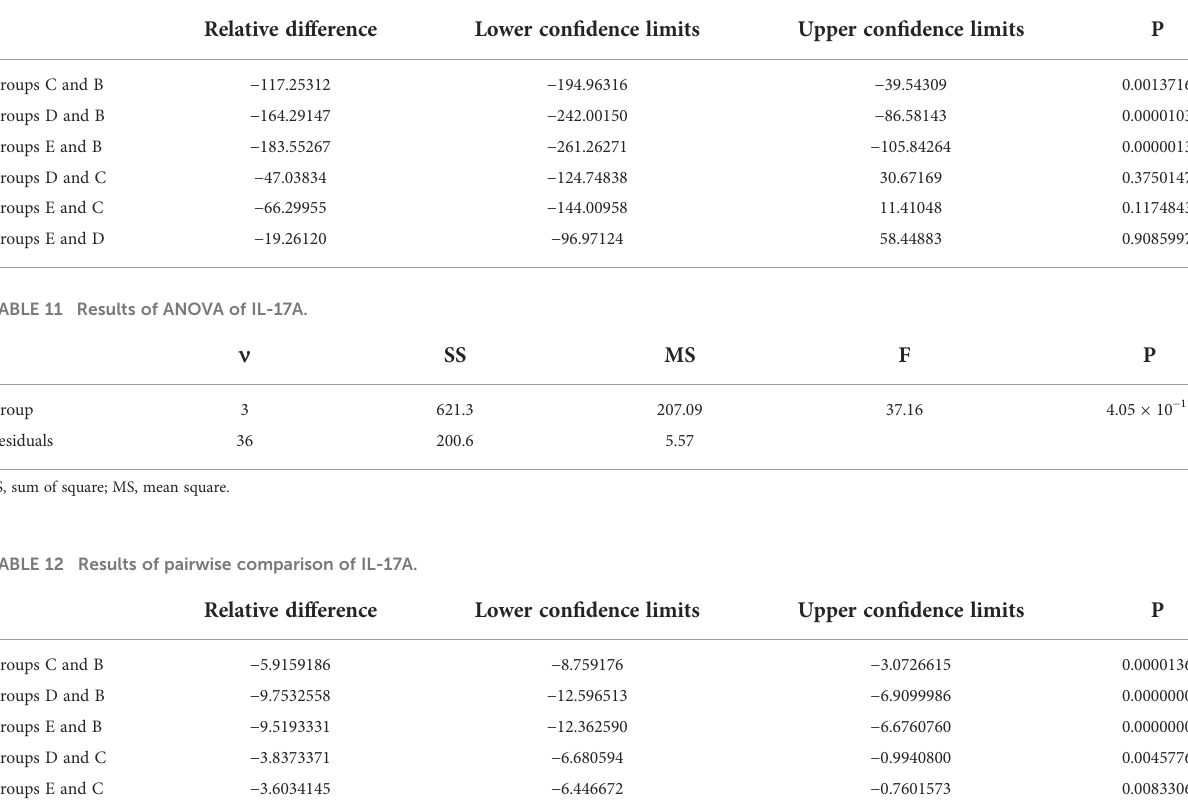
TABLE 10 Results of pairwise comparison of TNF- a .